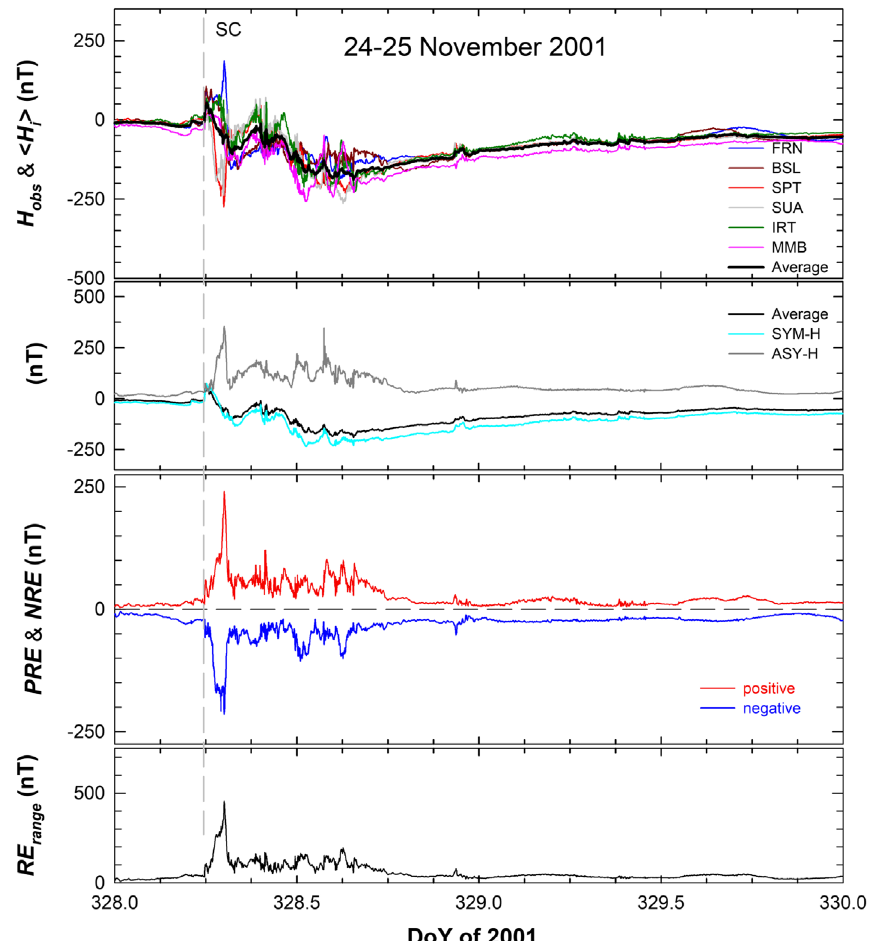
Fig. C.5. The event on 24 – 25 November 2001 (event